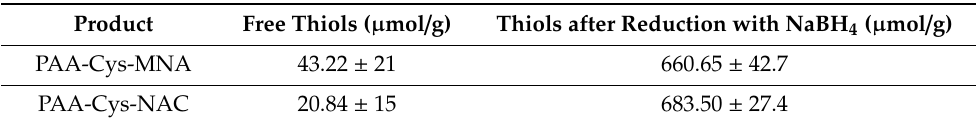
Figure 2. Synthesis of PAA-anhydride ( A ), PAA-Cys-MNA ( B ), PAA-Cys-NAC ( C ). Table 1. Amount of free thiols and thiols after reduction with NaBH 4 for s -protected thiolated PAA conjugates. The data are shown as mean ± SD (n =